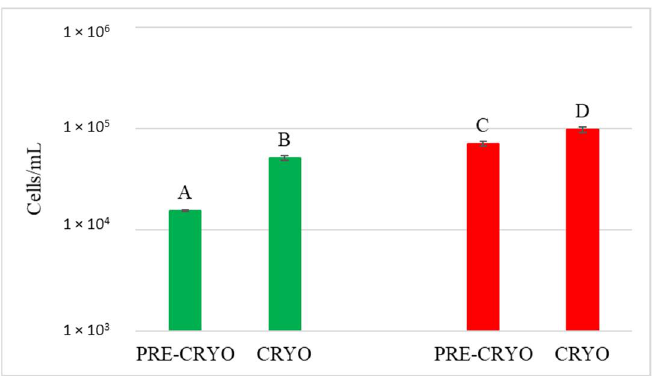
Figure 7. Starmerella bacillaris concentrations measured before (PRE-CRYO) and after (CRYO) cryomaceration. LCC: low cell concentration (green), HCC: high cell concentration (red). Data are expressed as the average of three replicates ± standard deviations. Different letters indicate significant differences between values ( p = 0.05).